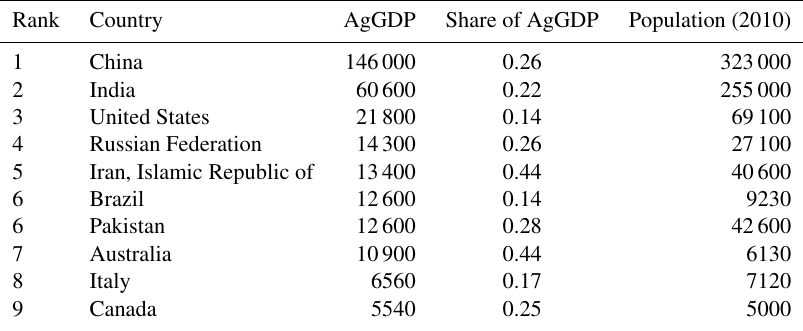
Table B1. Top 10 countries with the largest total agricultural GDP (millions of USD) exposed to dry areas with shares of agricultural GDP and population (thousands).